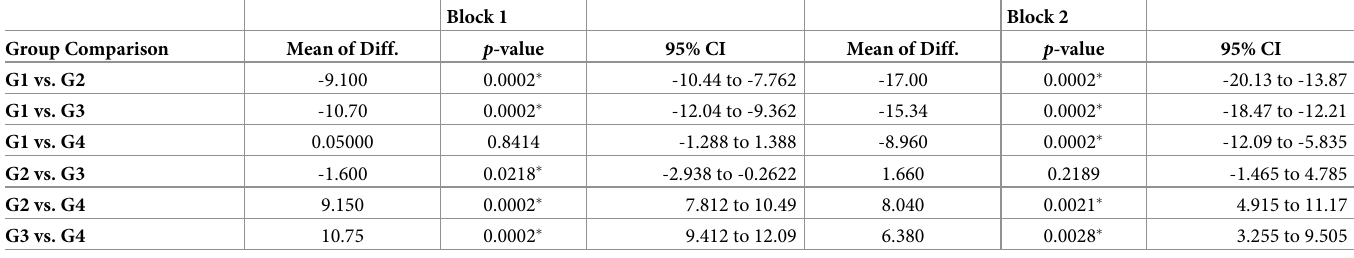
Table 2. Bonferroni’s multiple comparison test to compare Implant Stability Quotients (ISQs) between the groups in the two synthetic bone blocks. Block 1 Block 2 Group Comparison Mean of